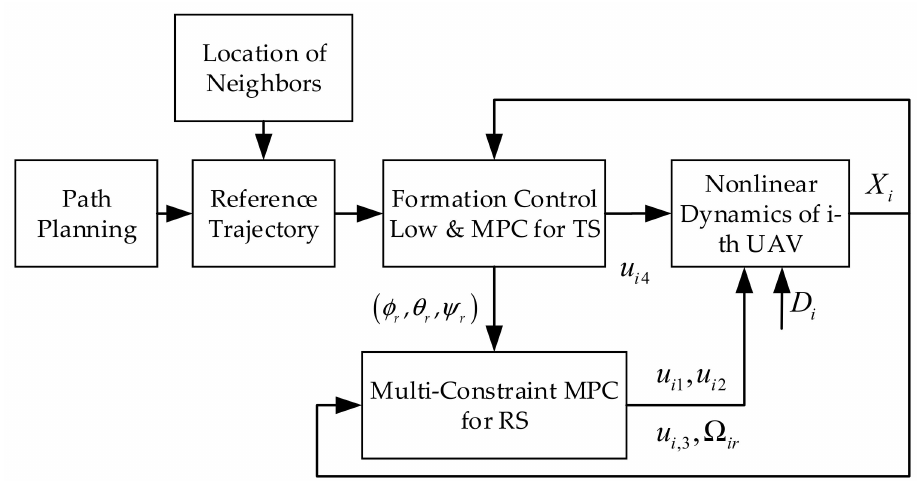
Figure 3. MPC of the UAV i